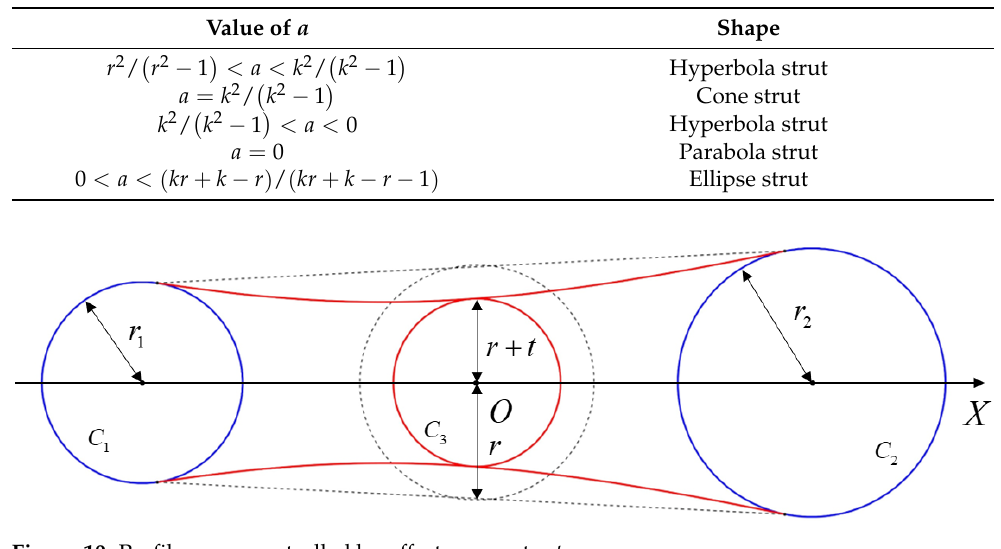
Figure 10. Profile curve controlled by offset parameter t .